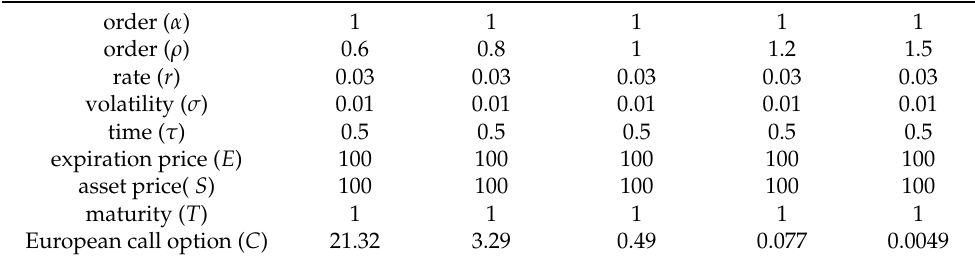
Table 1. Values of the European option with the different values of ρ